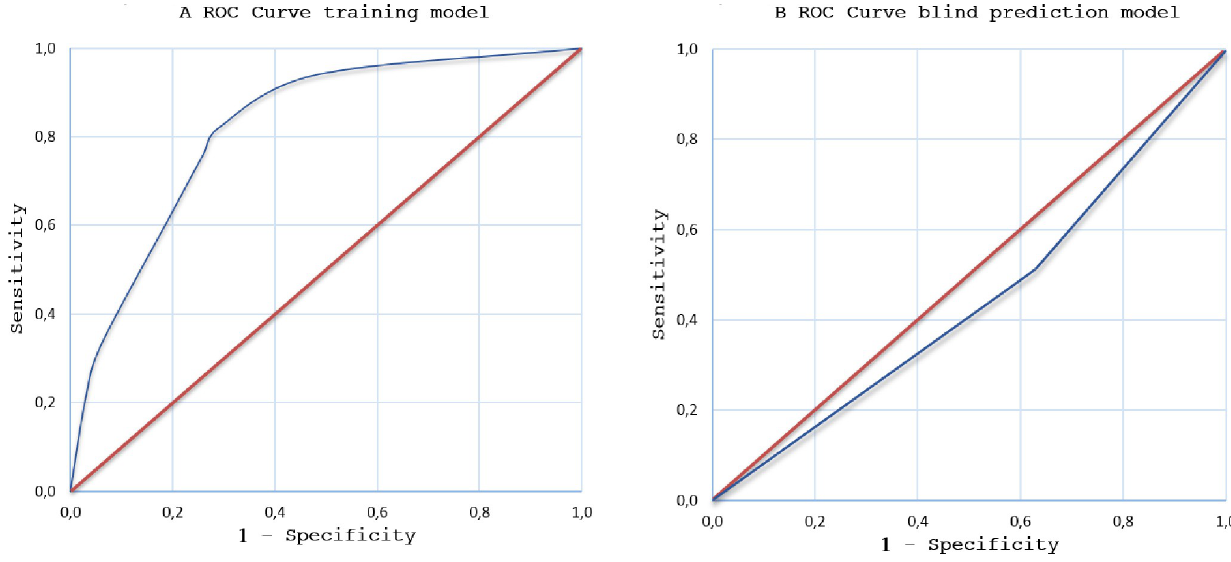
Fig 1. ROC curve of the training and the blind-prediction model.